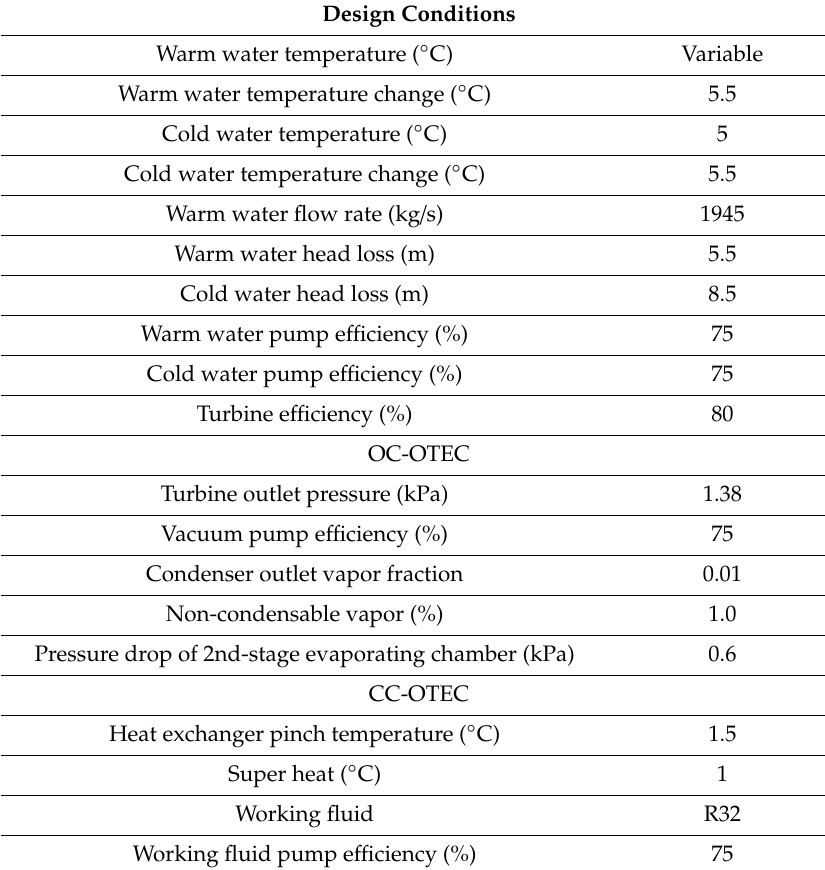
Table 3. Parameters of